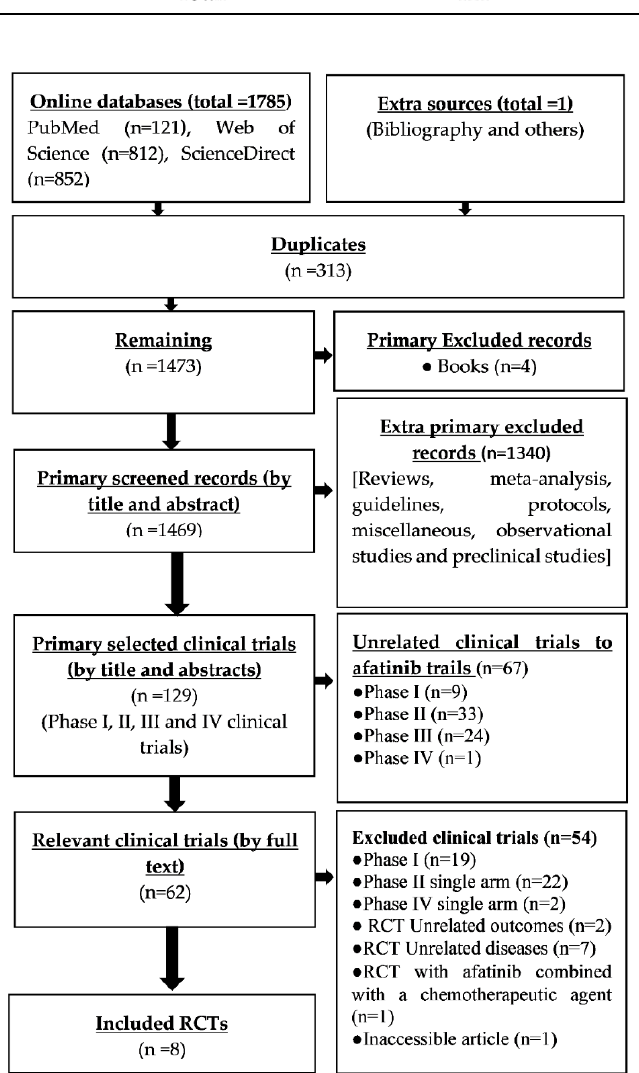
Figure 1. Flow chart of PRISMA.